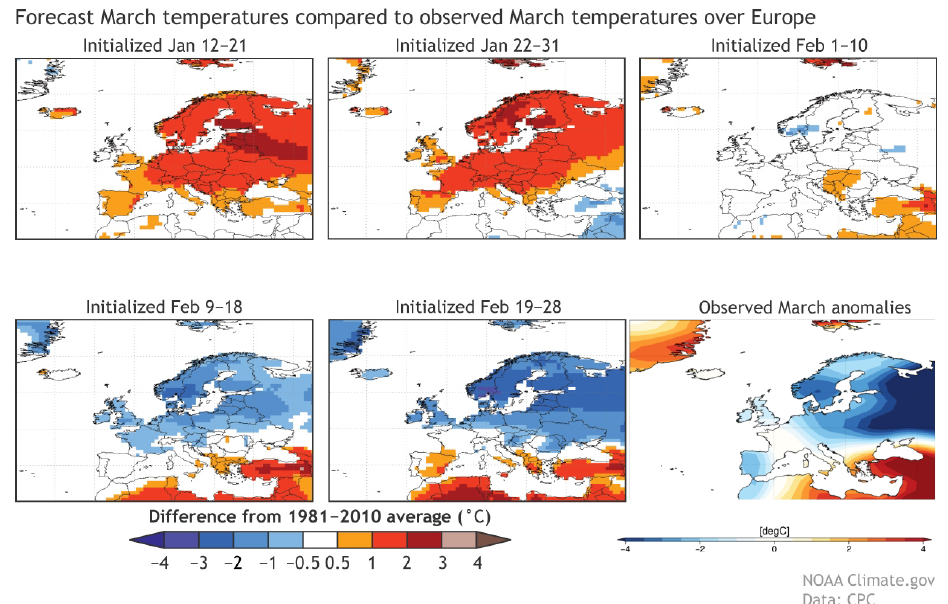
Figure 2. Forecast and observed monthly averaged temperature anomalies over land for March 2018 over Europe. Forecasts are from NCEP CFSv2, averaged over a total of 40 ensemble members, 4 of which are initialized on each date in the range of initial dates given in the captions. Observations are from the NCEP/NCAR